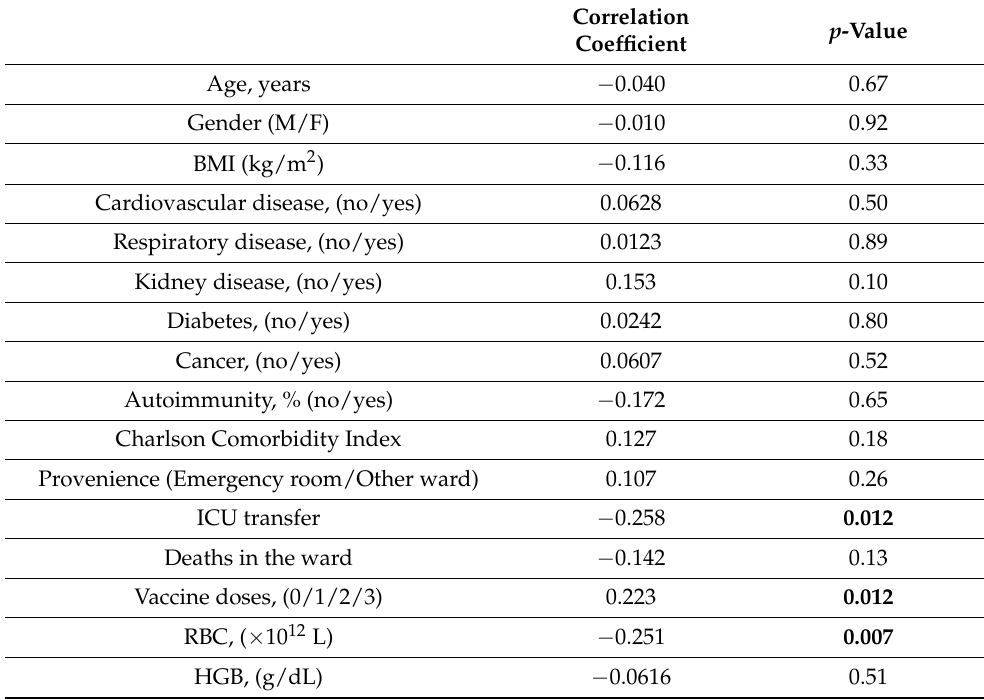
Table 2. Correlation between PaO 2 /FiO 2 ratio and demographic, clinical, and laboratory characteris- tics of the studied population on